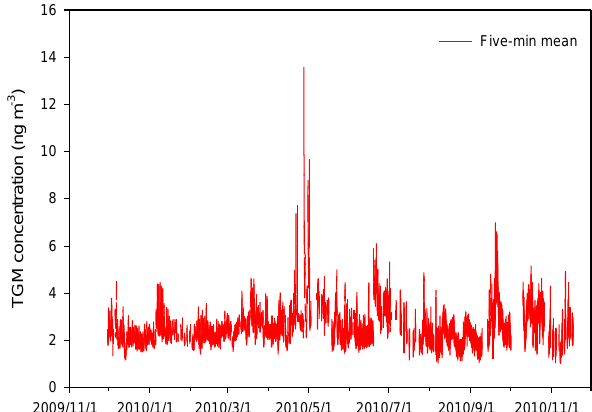
Figure 2. The 5-min time series distribution of TGM concentrations at SAWRS in the campaign. Spikes of high TGM concentrations were observed from late April through early May, from late June through early July and in late